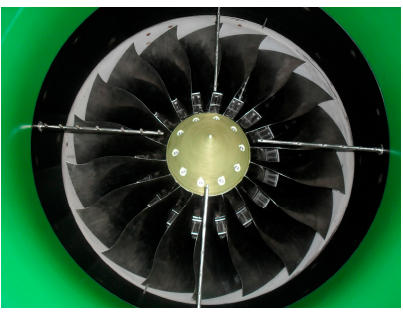
Figure 22. C180-2 stage.